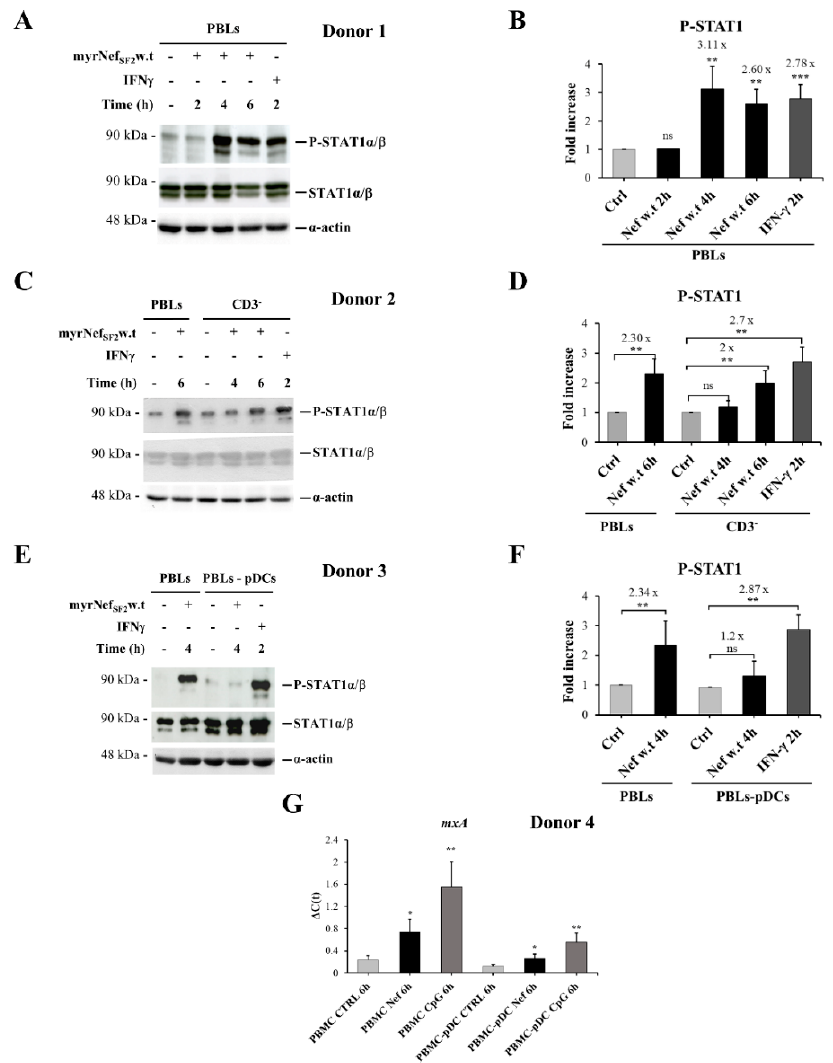
Figure 1. myrNef SF2 w.t induces the tyrosine phosphorylation of STAT1 in PBLs, but not in PBLs depleted of pDCs, and increases mxA expression. PBLs ( A ), PBLs depleted of CD3 + cells ( C ) and PBLs depleted of pDCs (PBLs-pDCs) ( E ) were seeded at 4 × 10 6 cells in a 12-well plate and treated with 300 ng/mL of myrNef SF2 w.t for the indicated time points. The treatment with IFN- γ (15 IU/mL) was used as a positive control. Cell lysates (50 µg of proteins) were analysed in 9% SDS-PAGE gel and the immunoblotting was performed using a phospho-Tyr(701)-STAT1 specific antibody. Anti- α -actin was used as an internal control of the loaded samples. ( B , D , F ) P-STAT1 was normalized to actin by densitometric analysis and reported as fold increase compared to control. ( G ) PBMCs and PBMCs depleted of pDCs (PBMCs-pDCs) were seeded at 2 × 10 6 /2 mL and treated for 6 h with 300 ng/mL of myrNef SF2 w.t or 1 µM of CpG A as a positive control. Ctrl: untreated cells. After treatment, cells were harvested and processed for RNA extraction. mxA expression was evaluated by qRT-PCR and the data were normalized using the 2- ∆ Ct formula, where ∆ Ct represents the difference between the amplification cycles of mxA gene and the amplification cycles of the housekeeping gene GAPDH (glyceraldehyde-3-phosphate-dehydrogenase), constitutively expressed in all cell types. The experiments were performed using four different donors. Histograms: mean ± S.D. One-way ANOVA test; *, p < 0.05; **, p < 0.01; ***, p < 0.005; ns, not significant vs. respective Ctrl (untreated cells).